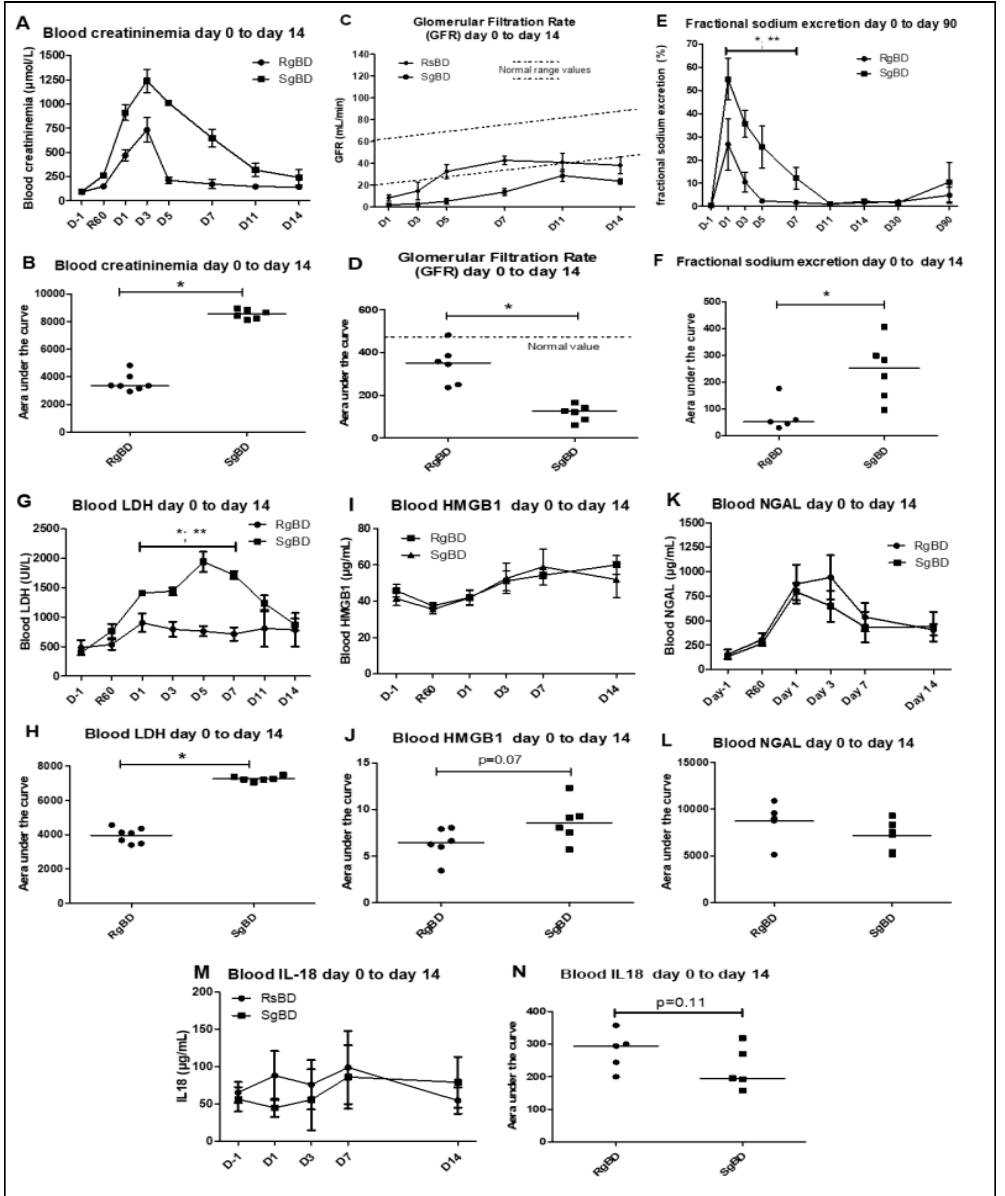
Figure 1. Renal function evaluation from day 0 to day 14 after transplantation. Renal function evaluation of the first 14 days after allotransplantation of kidneys subjected to rapid brain death induction (RgBD) or slow brain death induction (SgBD). Blood creatinine ( A , B ), glomerular filtration rate in mL / min ( C , D ), fractional sodium excretion ( E , F ), blood LDH ( G , H ), blood high mobility group box 1 (HMGB1; I , J ), blood NGAL ( K , L ) and blood IL-18 ( M , N ) were analyzed from the day before transplantation ( D – L ) to day 14 after transplantation. ( n = 5 to 7 per group). Kinetic results ( A , C , E , G , I , K , M ) are expressed as mean ± SD, statistical analysis was performed with Kruskal–Wallis multiple-comparison Dunn’s test. Areas under the curve (AUC; B , D , F , H , J , L , N ) are expressed in a scatter plot with the median, statistical analysis was performed with a Mann–Whitney test. * RgBD vs SgBD; ** vs D-1 p <